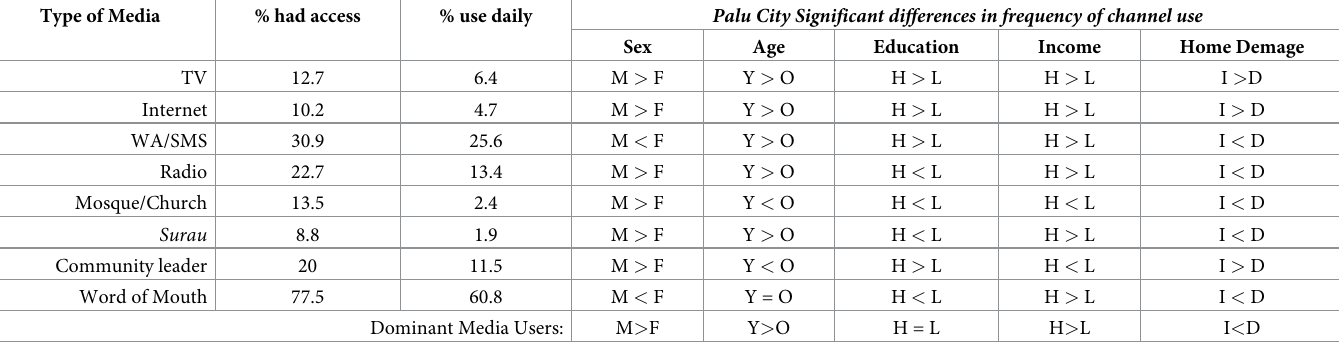
Table 1. Overall channel use patterns in Palu City.